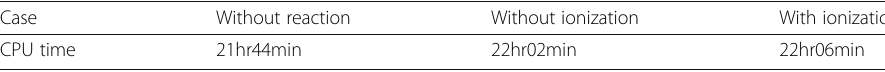
Table 4 CPU time for the test cases Case